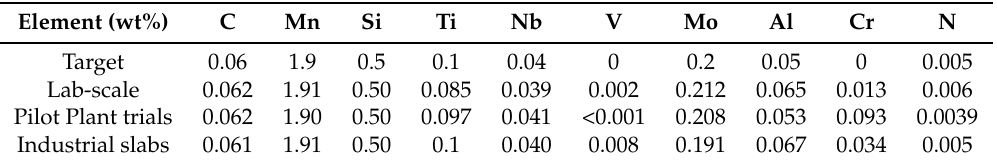
Table 1. Bulk composition of the steel used for preliminary investigations (Lab scale), for pilot plant trials, and for industrial trials, determined by